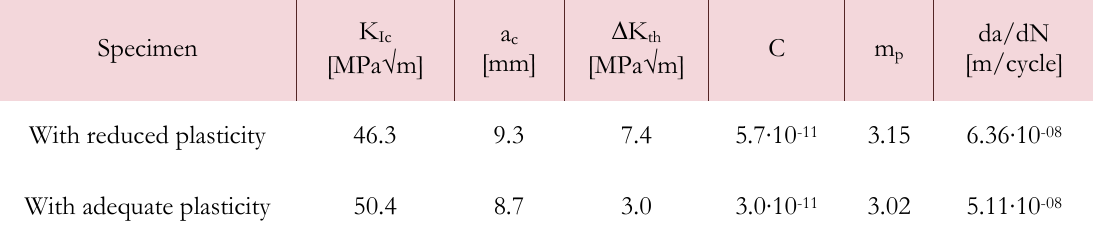
Table 1: Fracture mechanics parameters at 23°C, for the stress intensity factor range Δ K = 10 MPa  m.